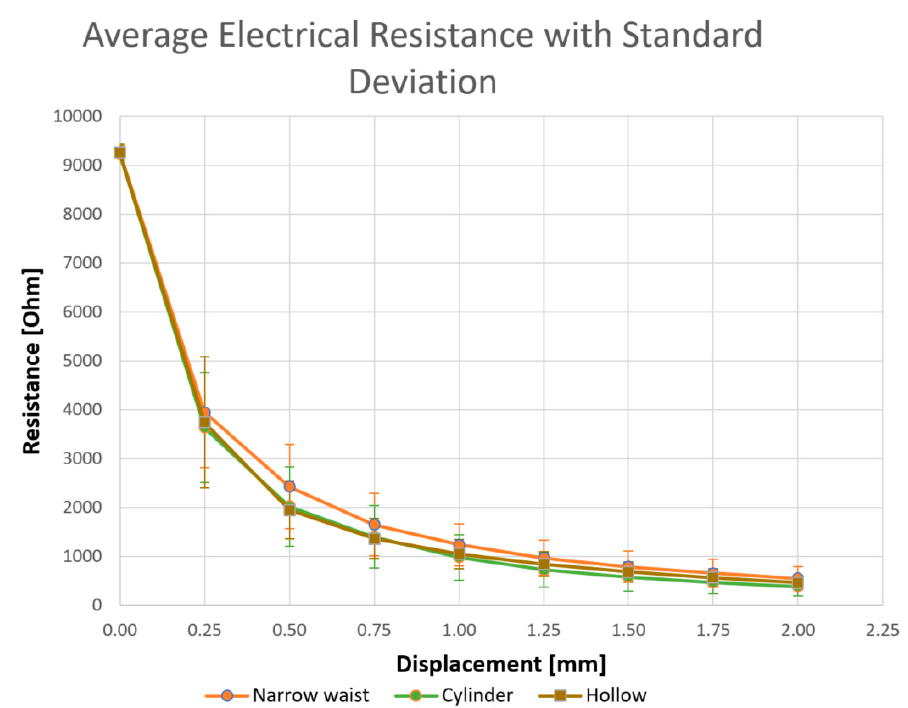
Figure 5. Measured electrical resistance and standard deviation of the different configurations of 3D-printed sensors.